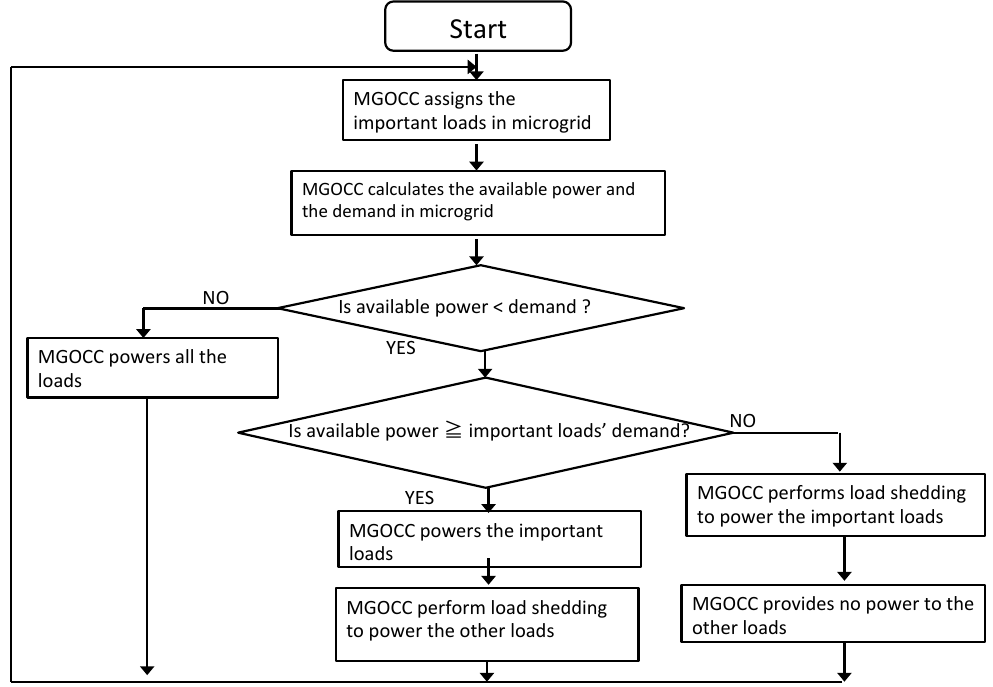
Figure 3. Overview of the proposed load shedding